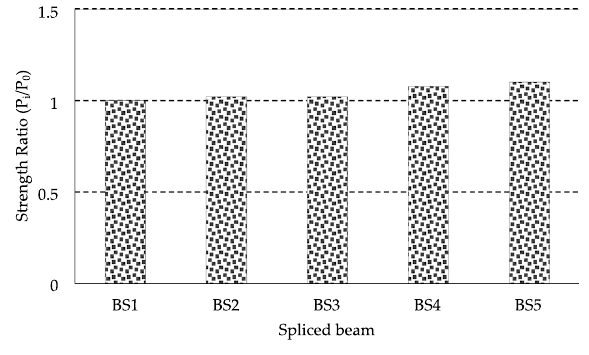
Fig. 6 Influence of splice length on beam flexural capacity